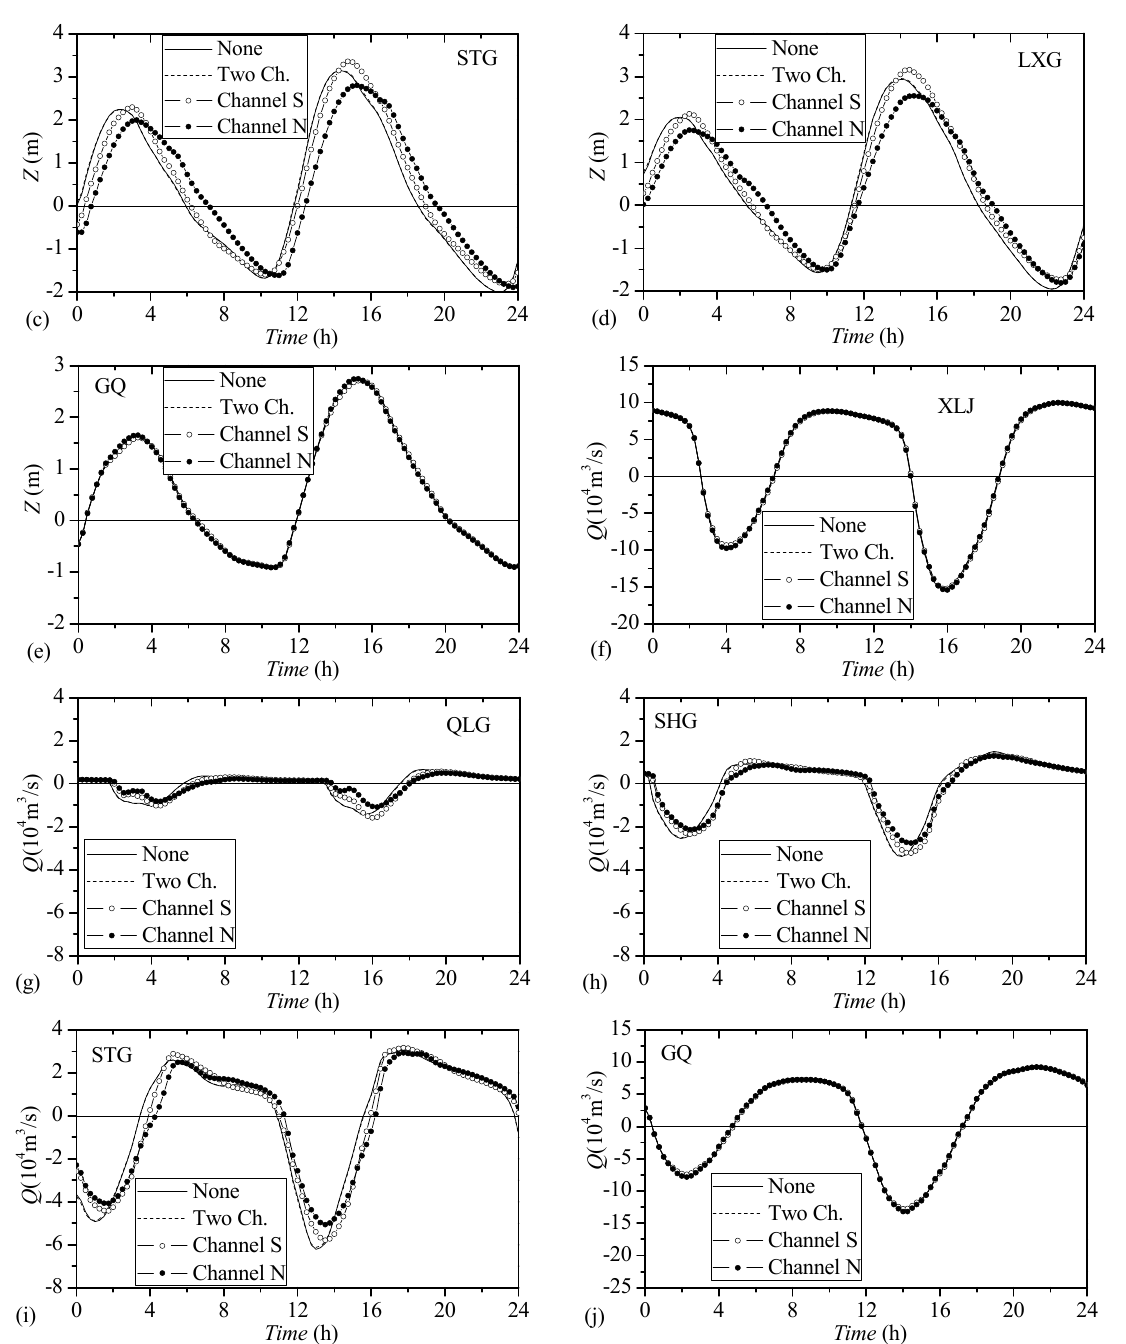
Figure 11. Histories of simulated water levels ( Z ) and discharges ( Q ) at cross-sections in the Yangtze Estuary: ( a – e ) Z processes; ( f – j ) Q processes.